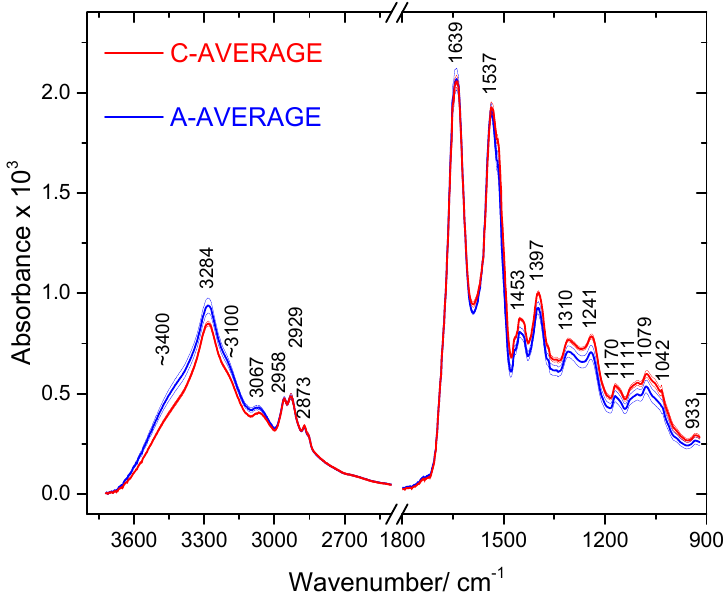
Figure 1. Average IR spectra of ASD (A-AVERAGE; thick blue line) and control (C-AVERAGE; thick red line) groups’ blood serum samples (3700–2400 and 1800–900 cm − 1 regions). Thin lines account for the standard